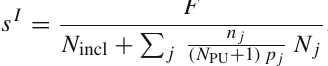
in Tables 5 and 6 into Eq. (11). For comparison, we also show the corresponding weight, given by s incl = F / N incl , for the case that only the inclusive sample is used to estimate